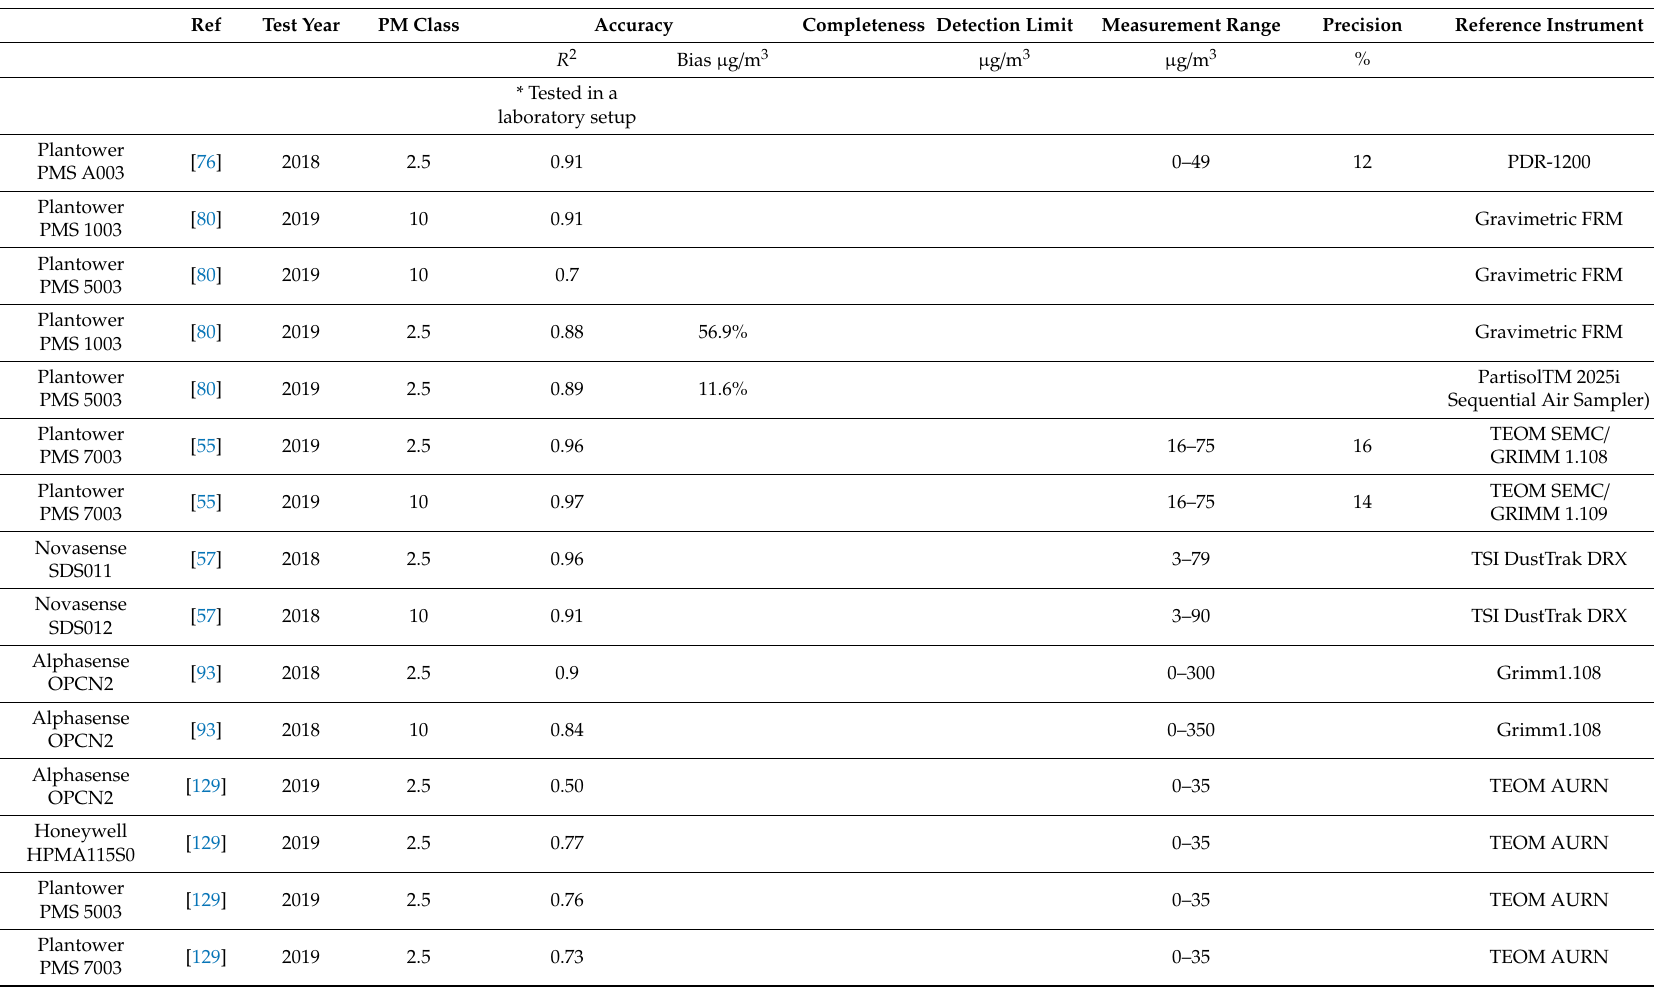
Table 8. The most meaningful LCPMS parameters. The columns report the quality parameters used to evaluate performance compared to a reference instrument, which is reported in the last